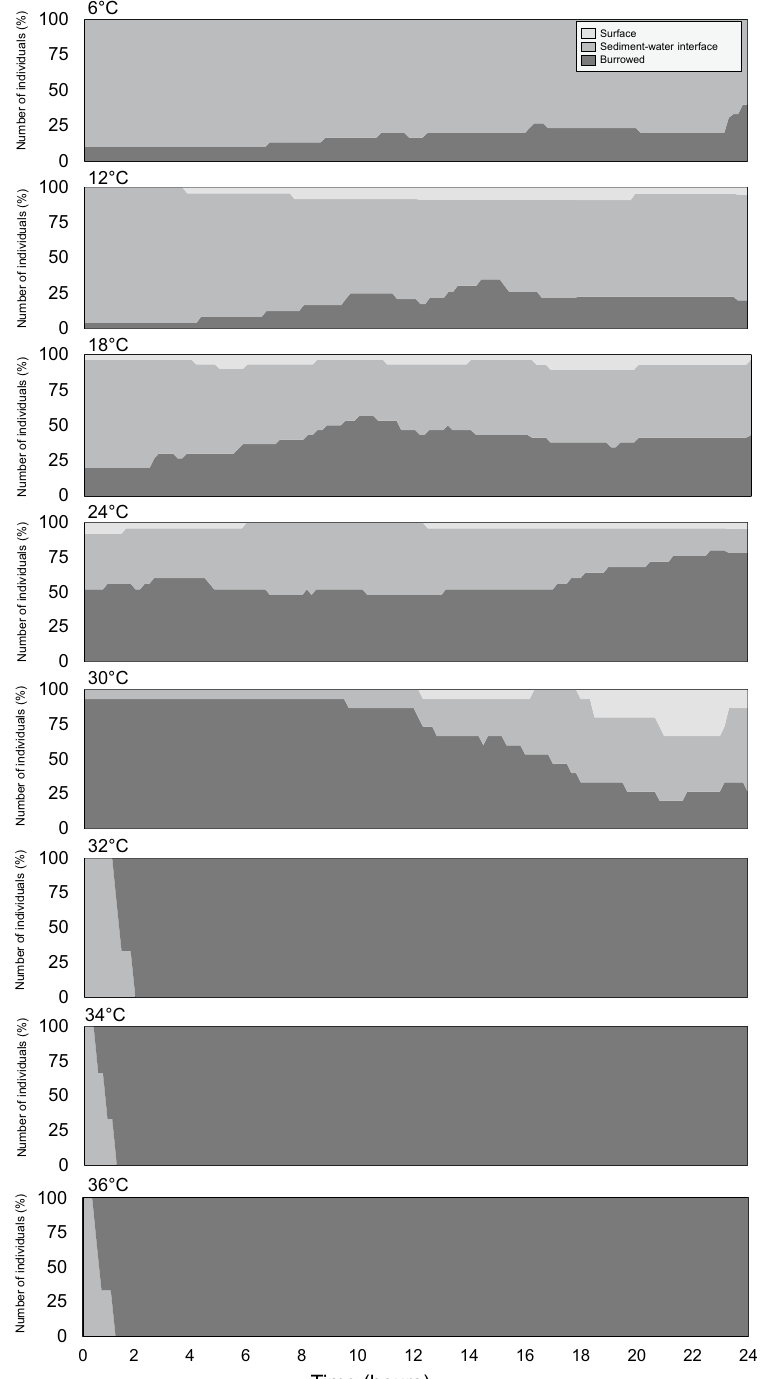
Figure 3. Temporal changes in the vertical position of H. germanica for each tested temperature. Number of individuals are shown in Supplementary Table